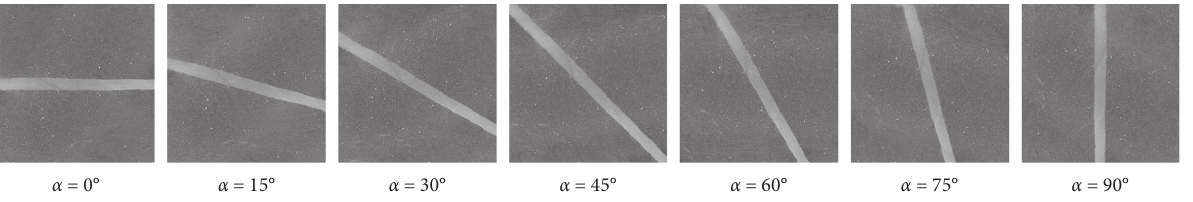
Figure 7: Digital image of jointed sandstone with distinct inclination.